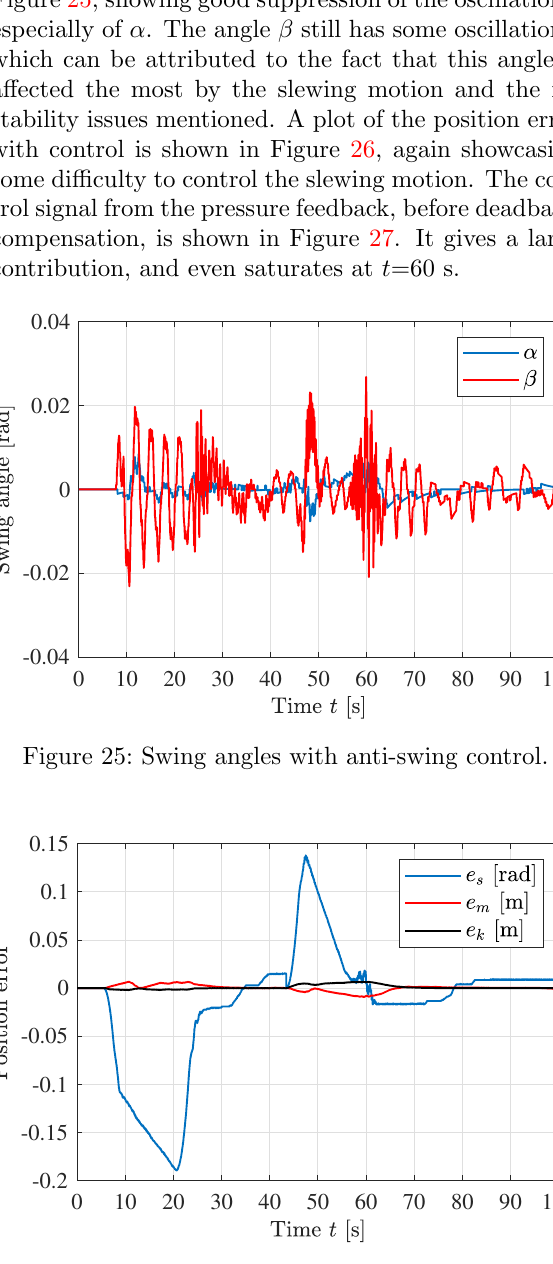
Figure 26: Position error with anti-swing